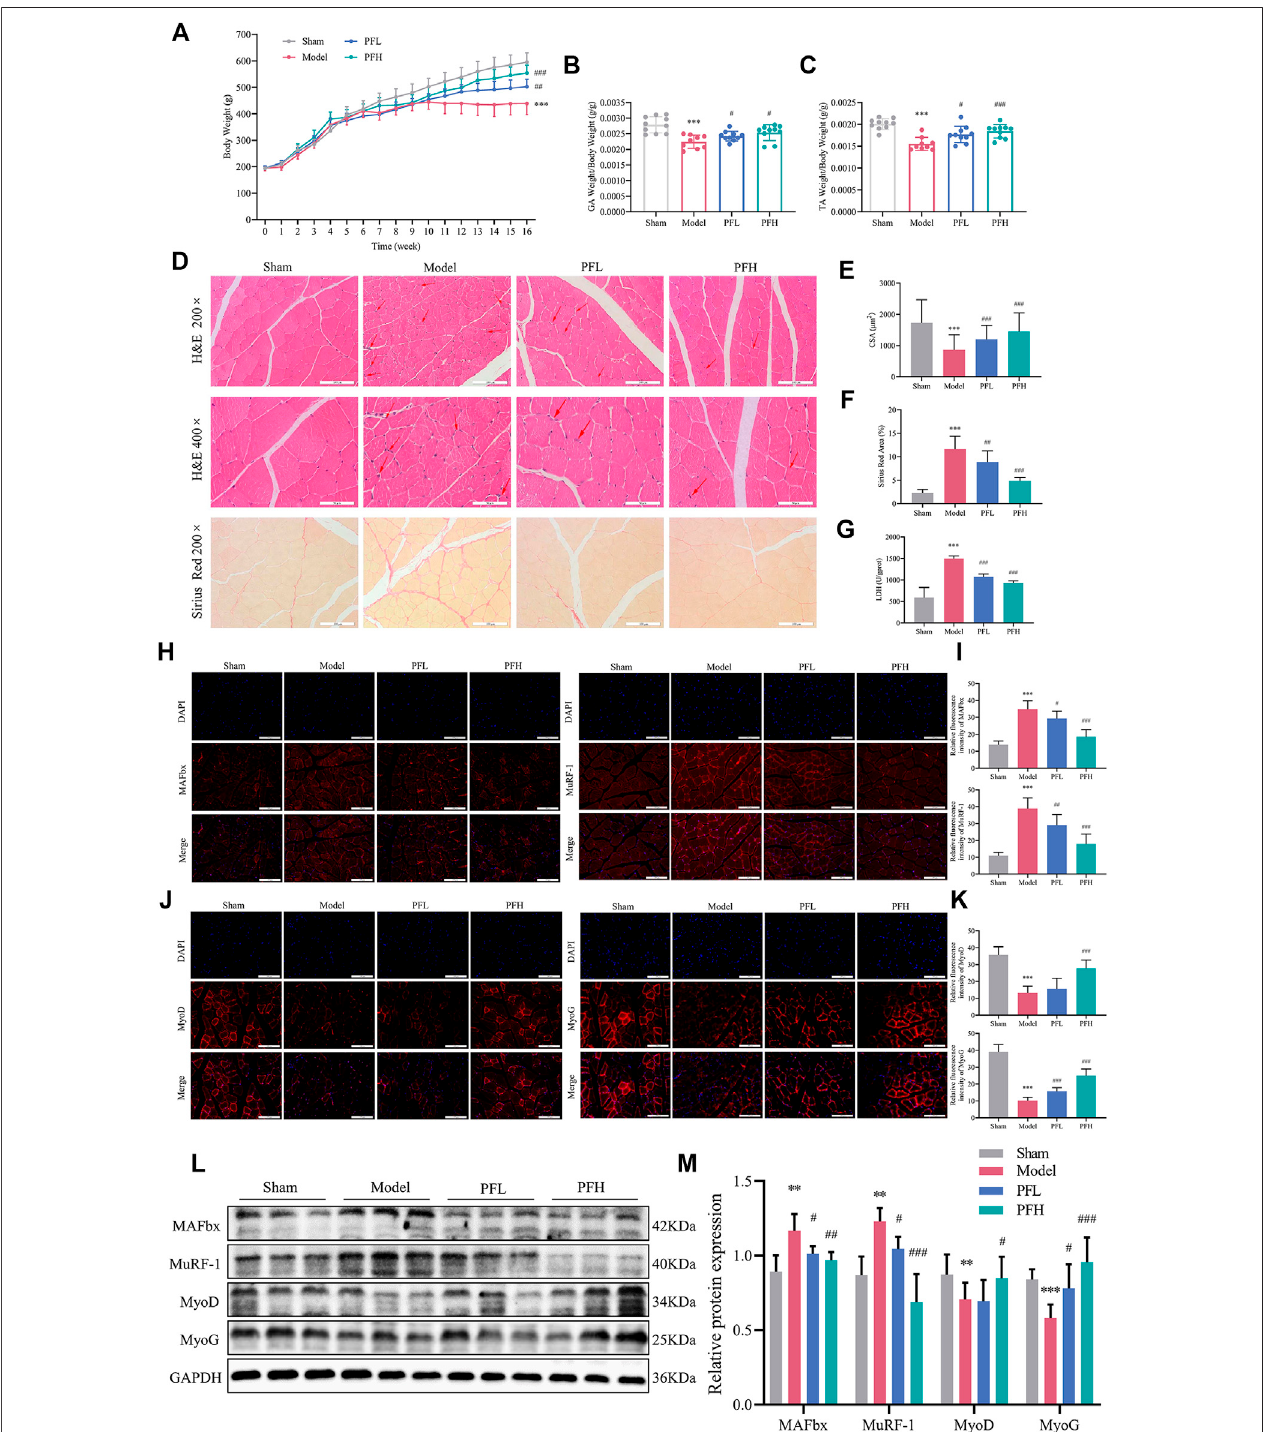
FIGURE 2 | PF inhibited skeletal muscle atrophy in CKD model rats. (A) Body weight was evaluated weekly throughout the entire 16-weeks experimental period. (B, C) Weights of GA and TA muscles normalized by the fi nal body weight. (D) Cross sections of TA muscle stained with H&E and Sirius Red. The red arrows indicate myo fi bersaffectedbyatrophy,suchasin fl ammatorycellin fi ltration,unevenmuscle fi berthicknessandcellnucleusdisplacement.RepresentativeimagesofH&Estaining (200× and 400×, scale bars: 100 and 50 μ m). Representative images of Sirius Red staining (200×). (E) The cross-sectional area (CSA) of the TA muscle fi bers of each group was measured (~150 myo fi bers in each group). (F) The Sirius red area of the TA muscles ( n = 15). (G) LDH levels in muscles. (H) MAFbx and MuRF-1 expression in the GA muscles was detected by immuno fl uorescence staining (200×, scale bars: 100 μ m) using antibodies against MAFbx (red) and MuRF-1 (red), and